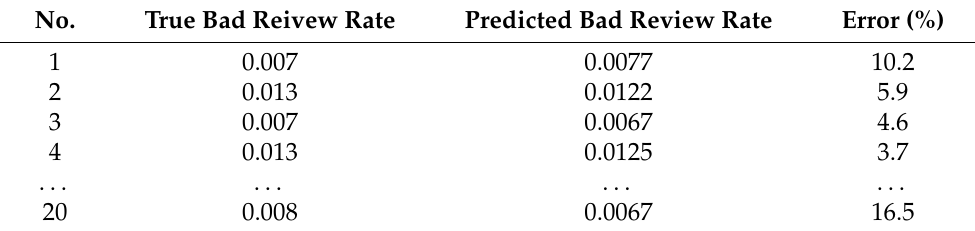
Table 6. True and predicted bad review rate with prediction